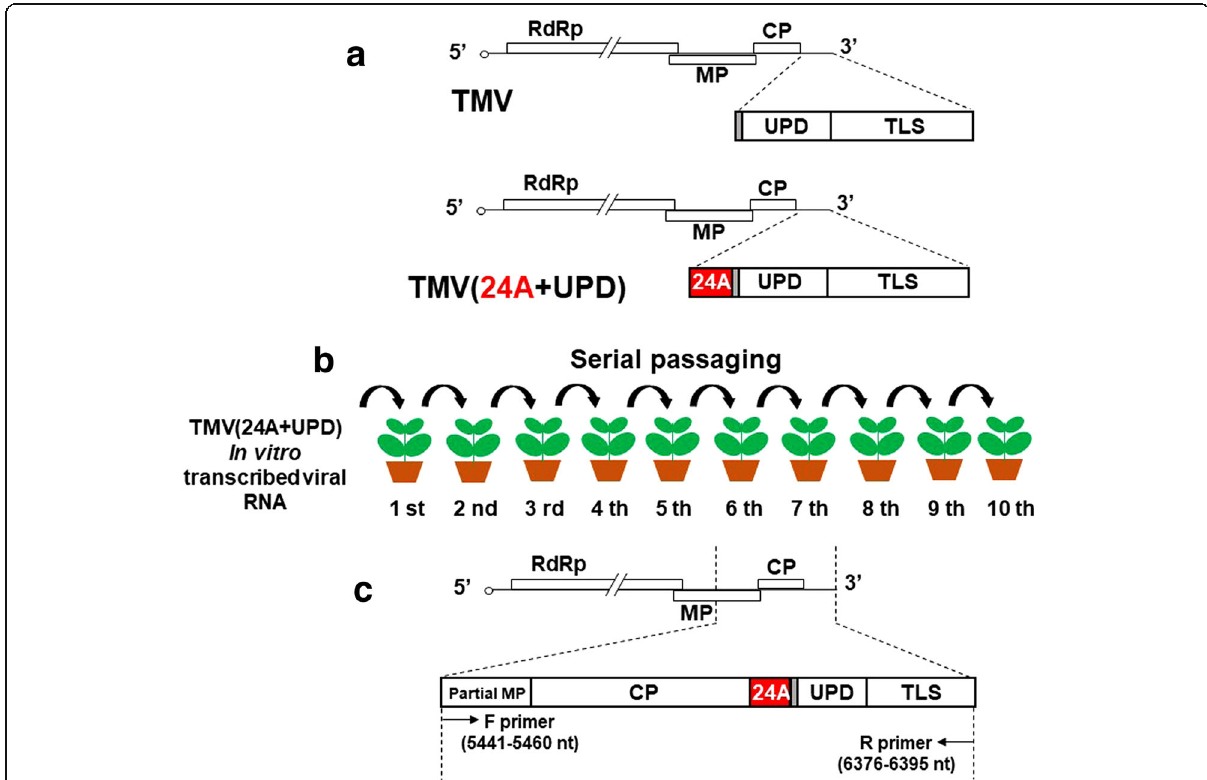
Fig. 1 a Schematic structures of TMV and TMV (24A + UPD) showing the internal poly(A) tract, upstream pseudoknot domain (UPD) and a short non-coding sequence (in grey color) between the internal poly(A) tract and the UPD. b Serial passaging of TMV (24A + UPD) in N. benthamiana plants. c Primers targeting regions in TMV (24A + UPD) genome are